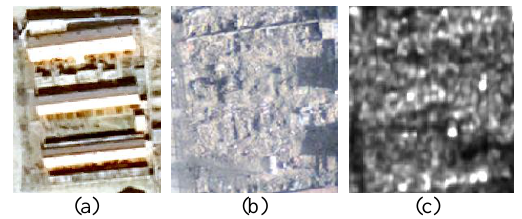
Figure 5. Pre-earthquake QuickBird image (a); post-earthquake airborne optical (b) and SAR (c) images of collapsed building.